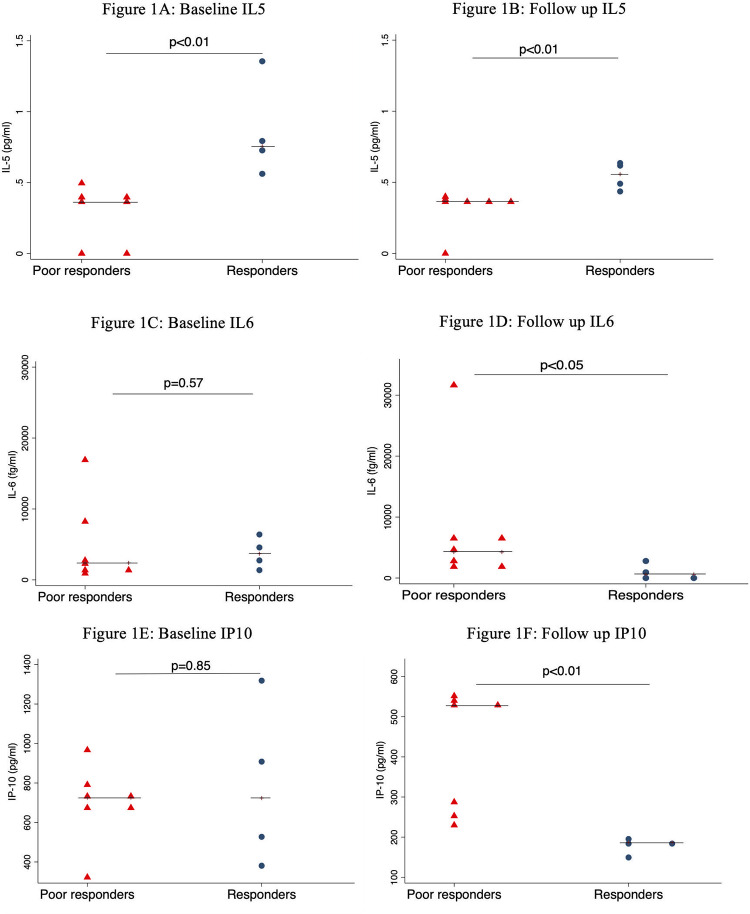
Cytokine levels in responders and poor responders.Bars represent median values.